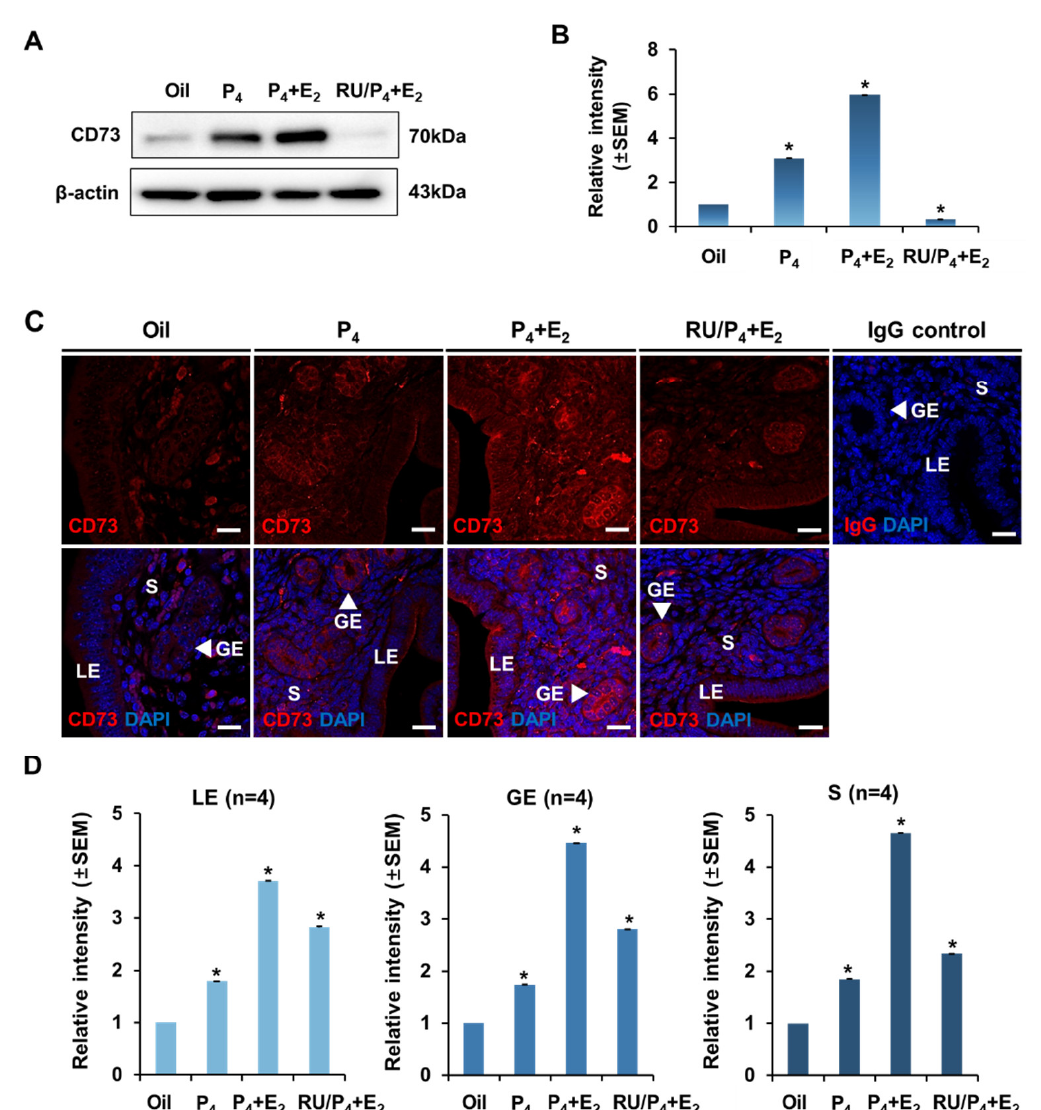
Figure 5. Expression of CD73 during simultaneous treatment of estrogen and progesterone. ( A ) Western blot analysis showed the expression of CD73 in the uterus of the OVX mouse treated with oil, P 4 + E 2 , or RU486 + P 4 + E 2 (RU/P 4 + E 2 ) (each group n = 4). β-actin was used for an internal control.